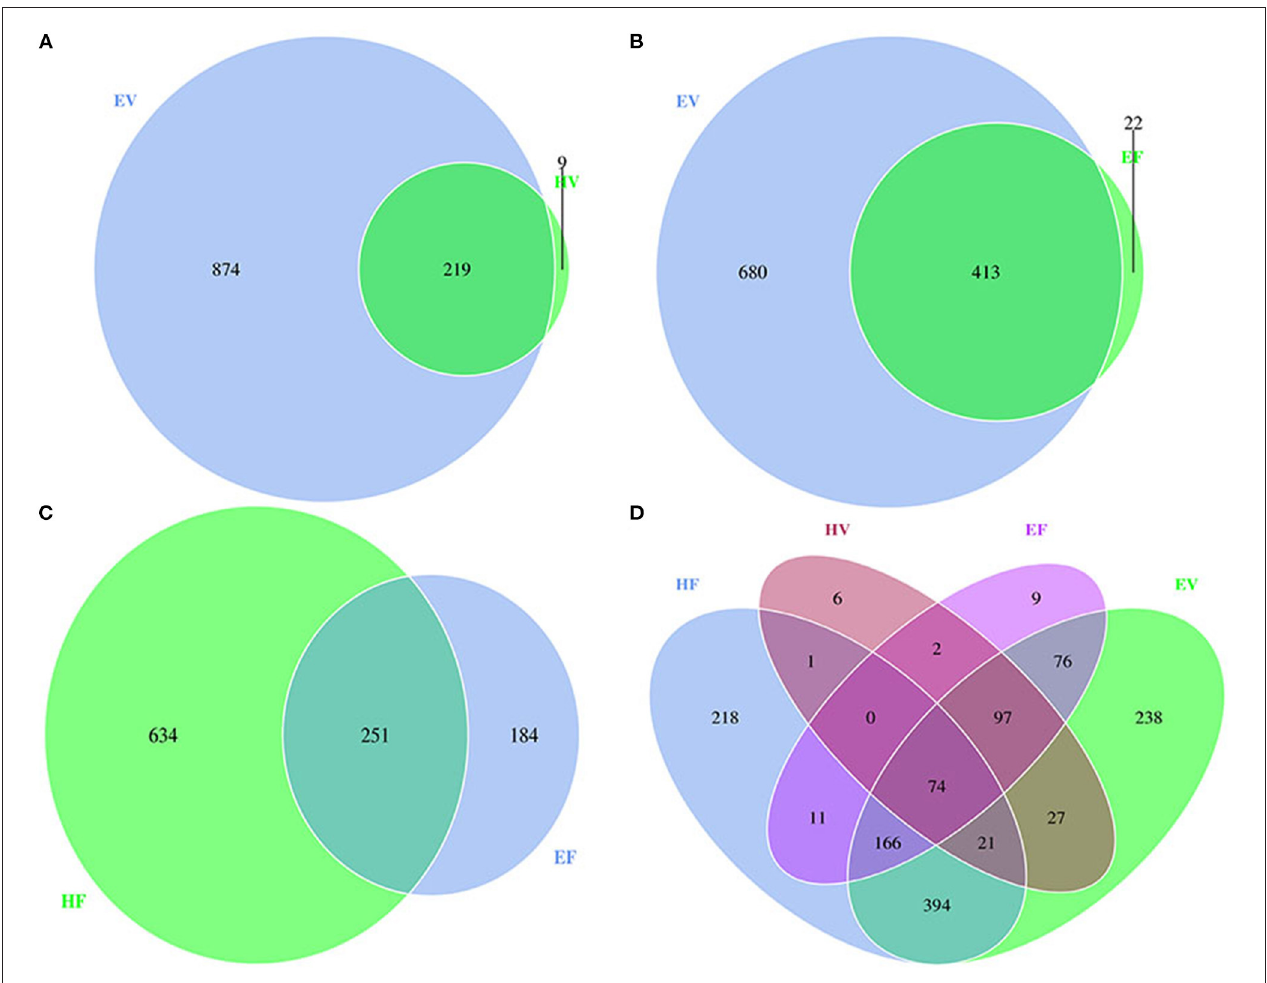
FIGURE 1 | Compositions of the microbiota of the sows feces and vaginal secretions. (A) The number of operational taxonomic units (OTUs) shared in endometritis vaginal secretion (EV) and healthy vaginal secretion (HV) samples are shown in Venn diagrams; (B) the number of OTUs shared in EV and endometritis feces (EF) samples are shown in Venn diagrams; (C) the number of OTUs shared in healthy feces (HF) and EF samples are shown in Venn diagrams; (D) the number of OTUs shared in HF, HV, EF, and EV samples are shown in Venn